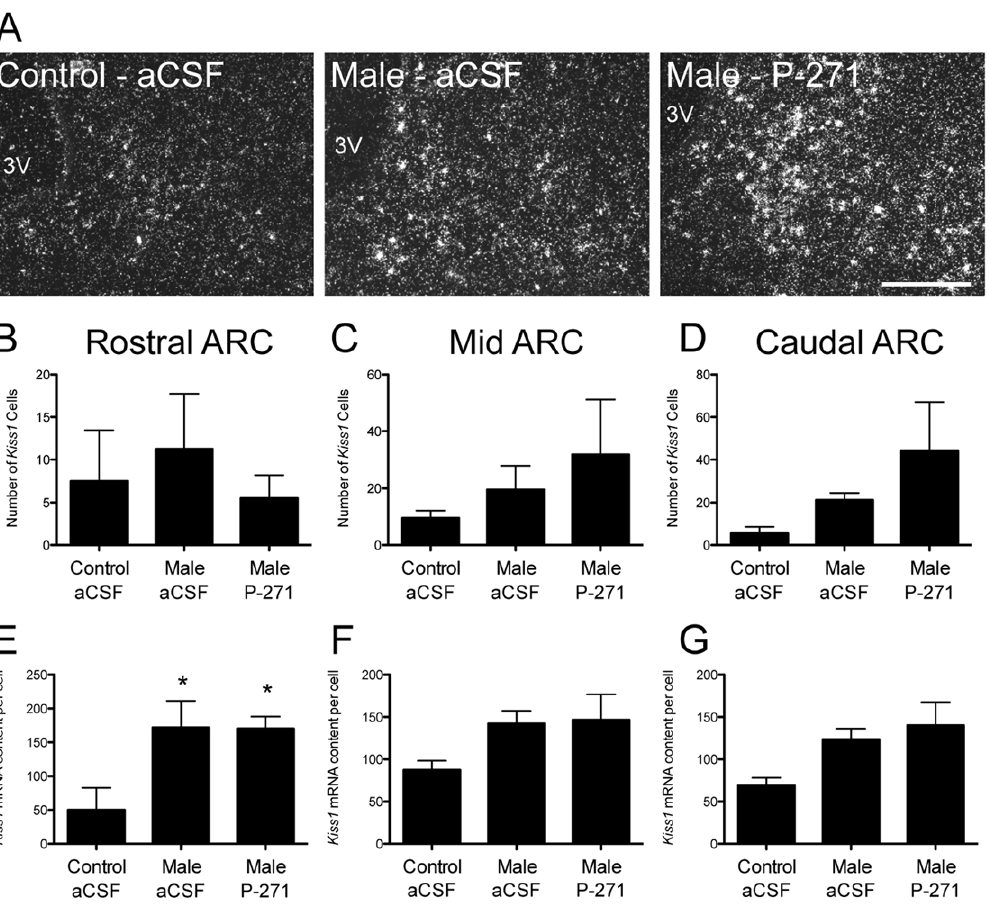
Figure 6. Male exposure in ewes increased the content of Kiss1 mRNA in the rostral ARC. A, Representative dark-field photomicrographs of the rostral ARC showing Kiss1 mRNA expressing neurons (as indicated by the presence of silver grain clusters). 3V, Third ventricle. Scale bar , 200 m m. B–C, Kiss1 mRNA content per cell was significantly greater in anestrous ewes exposed to males compared to non-exposed controls in the rostral ARC (B). P-271 had no effect on Kiss1 mRNA content. Data are the mean 6 SEM, *P , 0.05, n=4 per group.